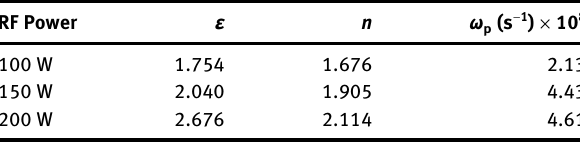
Table  : Values of dielectric constant ( ε ), refractive index ( n ), and plasma frequency ( ω p ) from NiO, extracted from Ref. [ 